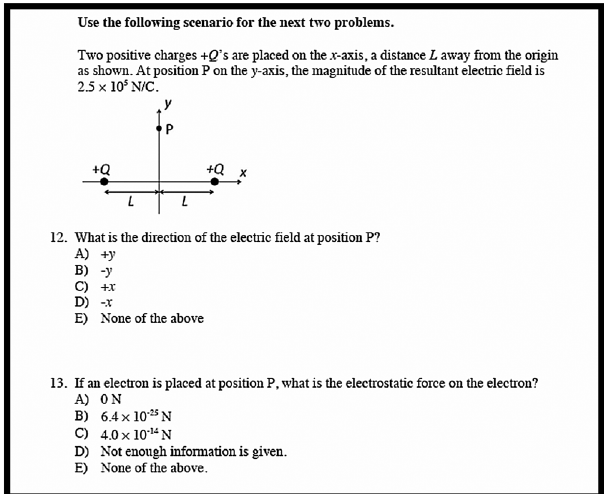
FIG. 4. Two exam questions about electric field and force from one of the institutions. Question 12 was categorized as lab related while question 13 was categorized as not lab related.